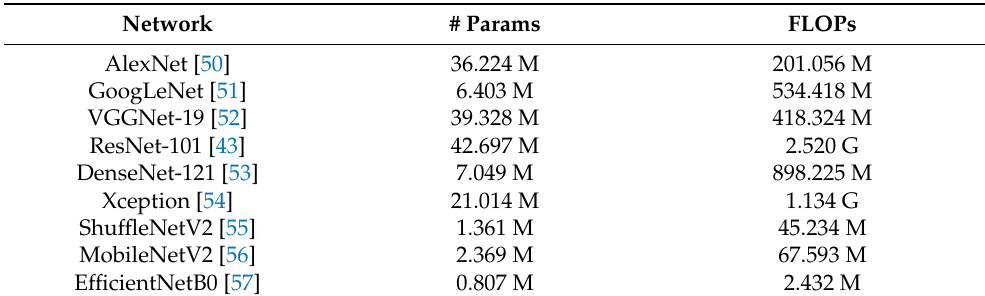
Table 6. Networks trained on CIFAR-100 and their parameter quantities as well as calculation overhead. Network # Params FLOPs AlexNet [50]